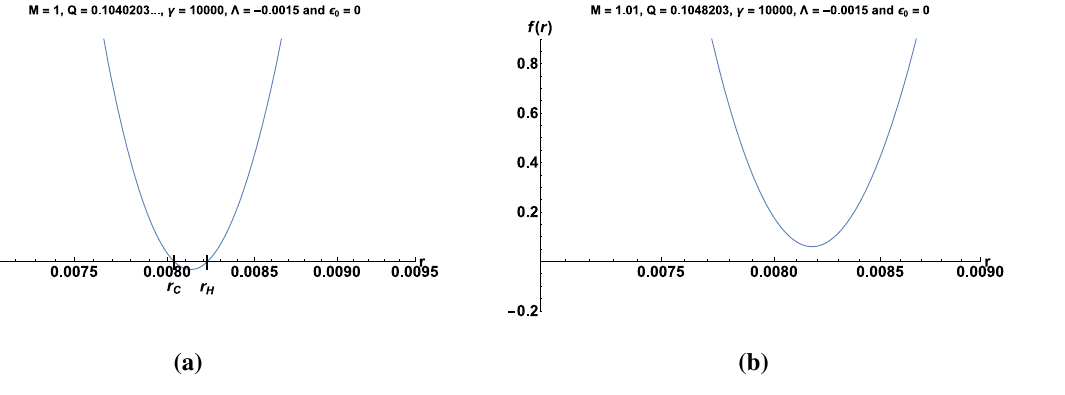
Fig. 5 An example of an over-extremal black hole created from a sub- extremal black hole in massive gravity background. The high-value γ allows the possibility of the sub-extremal charged particle being